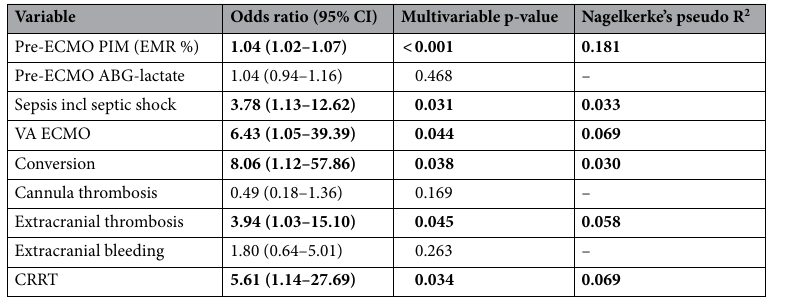
Table 3. Multivariable regression of possible predictors for brain infarction diagnosis during ECMO treatment. Bold text highlights significant statistically significant parameters in the last step of the multivariable analysis (p-value < 0.05). All these variables were initially included in the multivariable analysis and excluded in a step-down regression model, were variables that did not meet the criteria for further inclusion, i.e., a p-value > 0.05, were excluded. Nagelkerke’s pseudo R 2 for each of the significant variables is reported. Total pseudo R 2 for the final multivariable model was 0.34. ABG = arterial blood gas, CI = confidence interval, CDH = congenital diaphragmatic hernia, CRRT = continuous renal replacement therapy, ECMO = extracorporeal membrane oxygenation, ECPR = extracorporeal cardiopulmonary resuscitation, EMR% = estimated mortality rate in percent, MAS = meconium aspiration syndrome, PIM = pediatric index of mortality, PPHN = persistent pulmonary hypertension in the newborn, VA = veno-arterial.